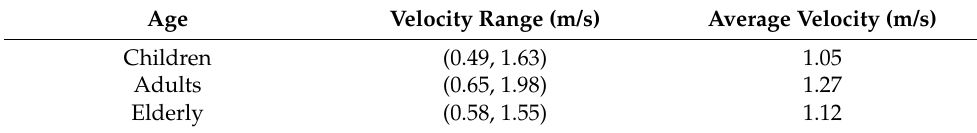
Table 3. The evacuation velocity of people of different ages